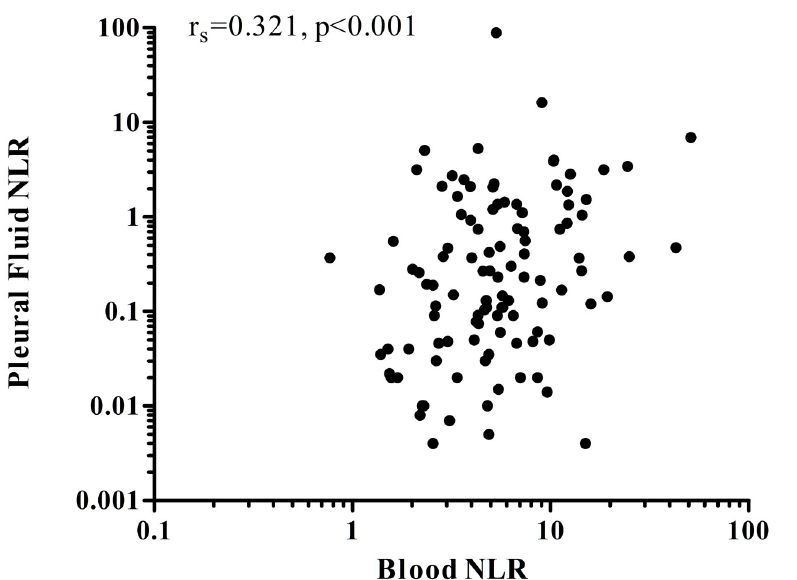
Fig 3. Correlation between blood and pleural fluid NLR in patients with